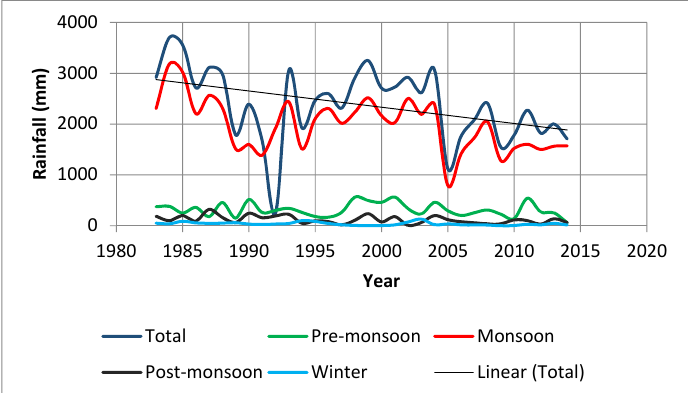
Figure 5. Rainfall trend of Sindhuli Gadhi station. Climate 2017 , 5 , 11